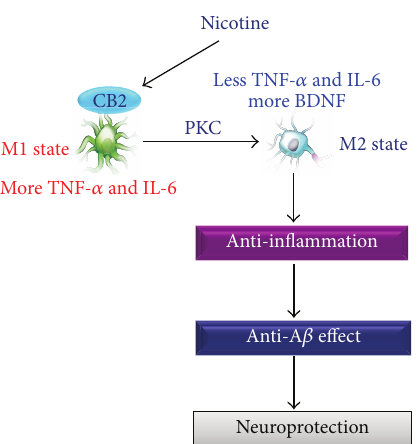
Figure 7: Hypothetical model of CB2 receptor mediates nicotine- induced neuroprotection against A 𝛽 toxicity in microglia. Nicotine exposure increases microglial CB2 receptor expression, which then shifts microglial M1 to M2 state, leading to the result that less TNF- 𝛼 and IL-6and moreBDNF arereleased fromthecells, and theprocess is mediated by PKC. Then the nicotine-induced anti-inflammation may happen, resulting in anti-A 𝛽 effect and